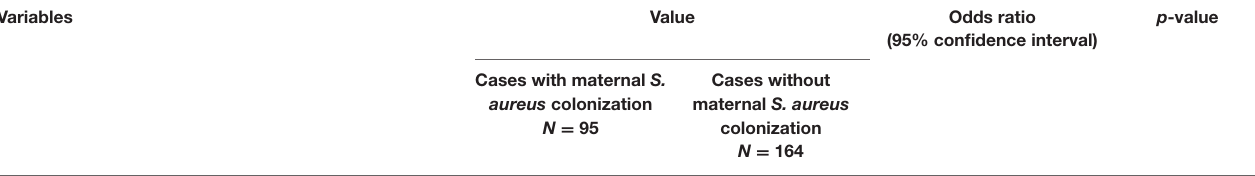
TABLE 2 | Univariate and multivariate analyses of clinical features of infants and mothers by maternal Staphylococcus aureus carrier status. Variables Value Odds ratio